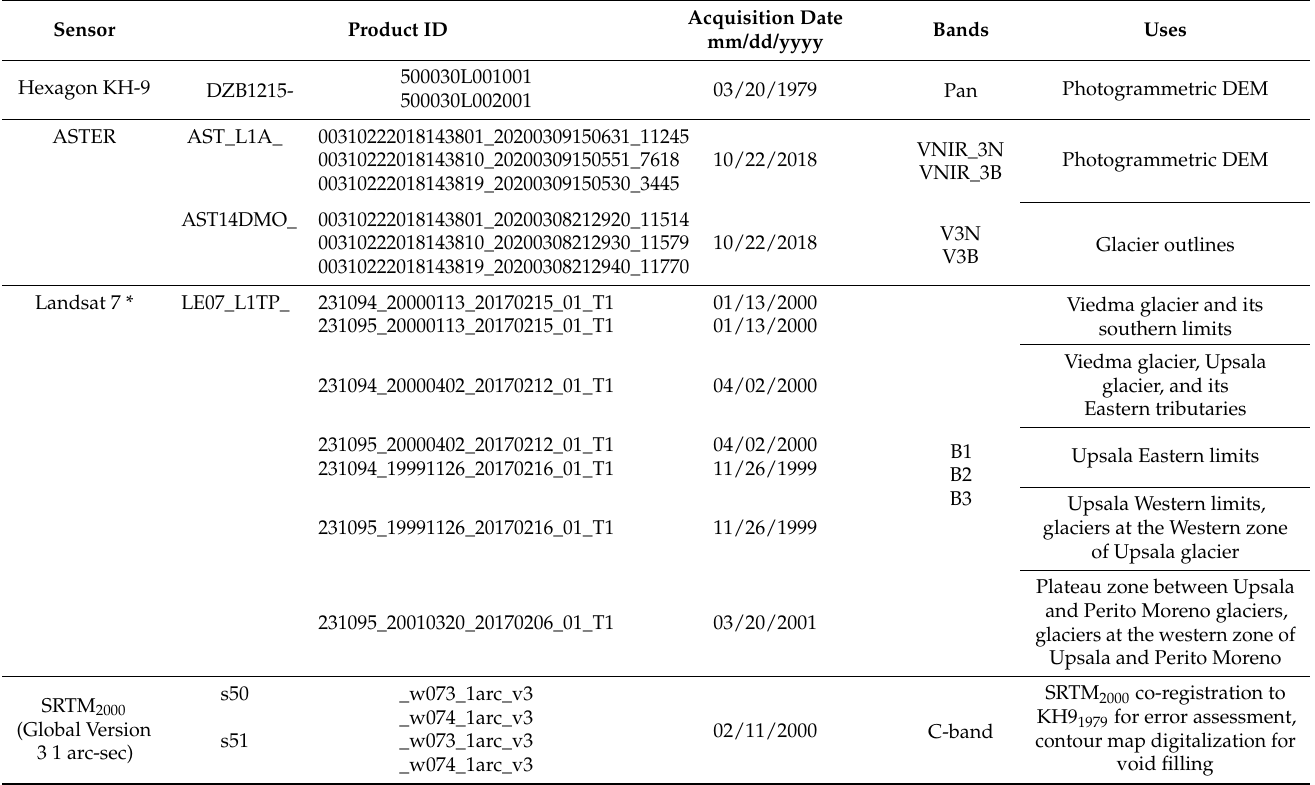
Table 1. Optical images employed, their characteristics and uses.